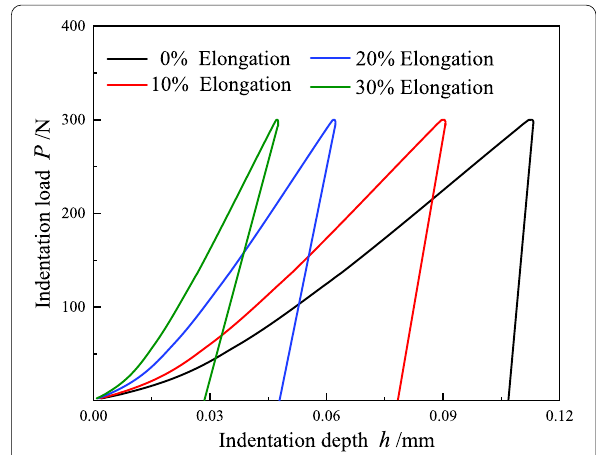
Figure 10 The load-depth curves obtained by indentation test under different elongations